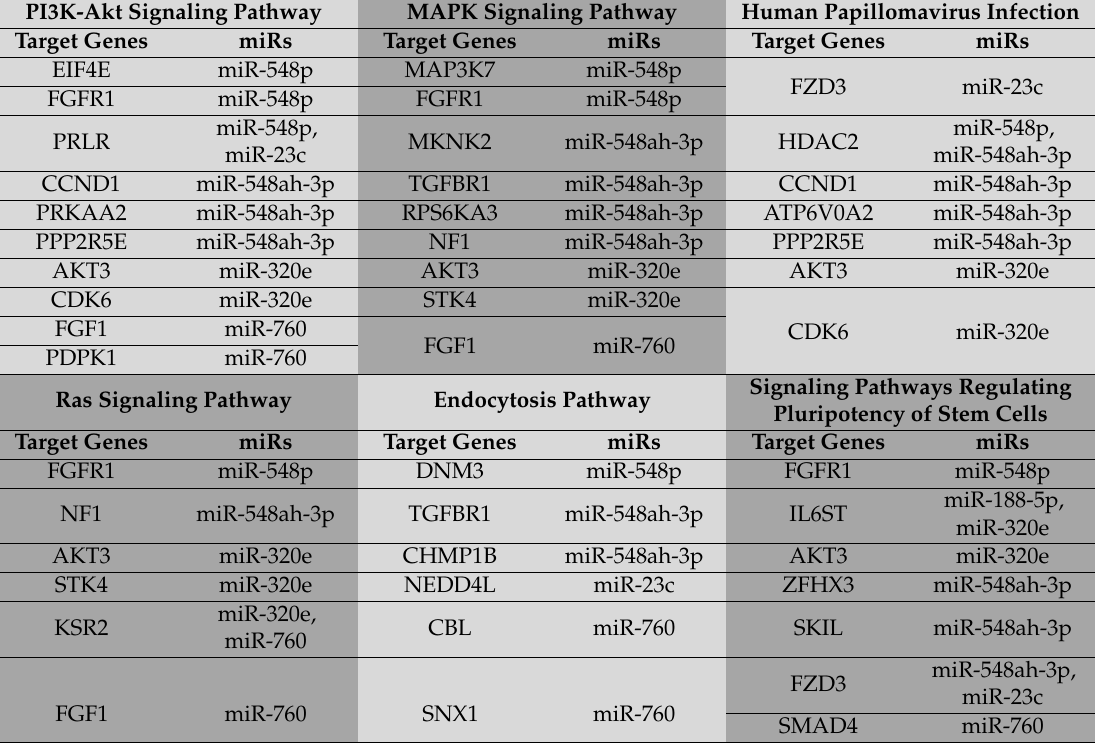
Table 4. Target genes, functional pathways and the miRs in nephrotic DN patients. PI3K-Akt Signaling